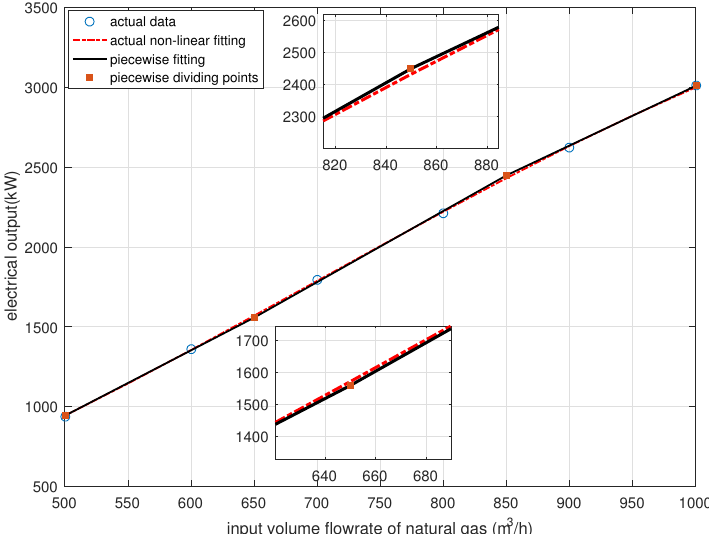
Figure 3. The three-segment piecewise linear function curve of